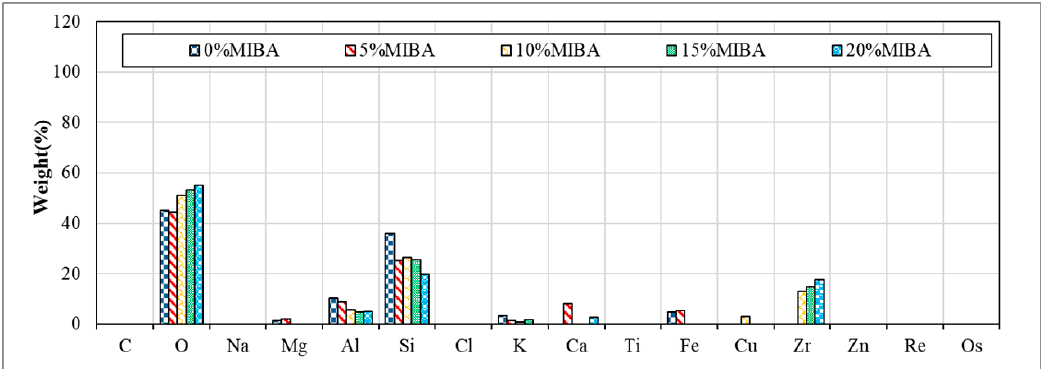
Figure 15. EDS of 20% SSA and various MIBA replacements at 1100 °C kiln temperature.